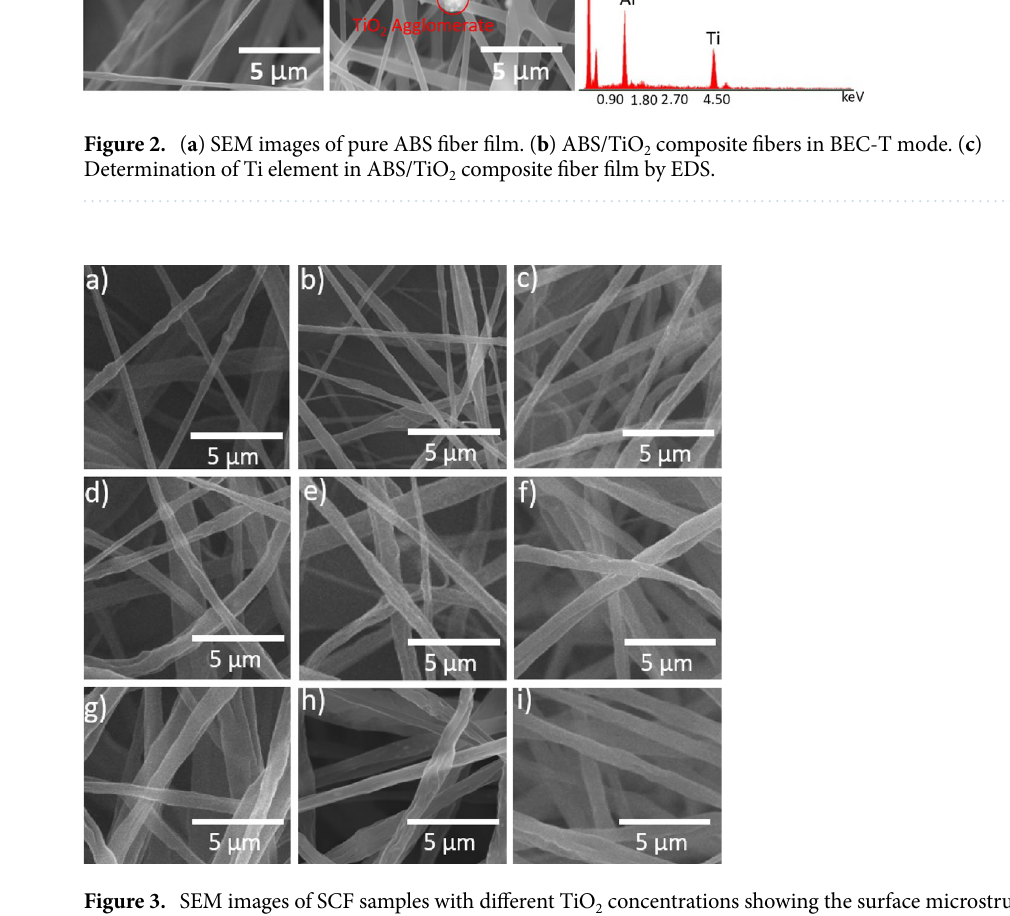
Figure 3. SEM images of SCF samples with different TiO 2 concentrations showing the surface microstructures of ABS/TiO 2 fibers with a TiO 2 concentration of ( a ) 0, ( b ) 5, ( c ) 10, ( d ) 15, ( e ) 20, ( f ) 25, ( g ) 30, ( h ) 35 and ( i ) 40